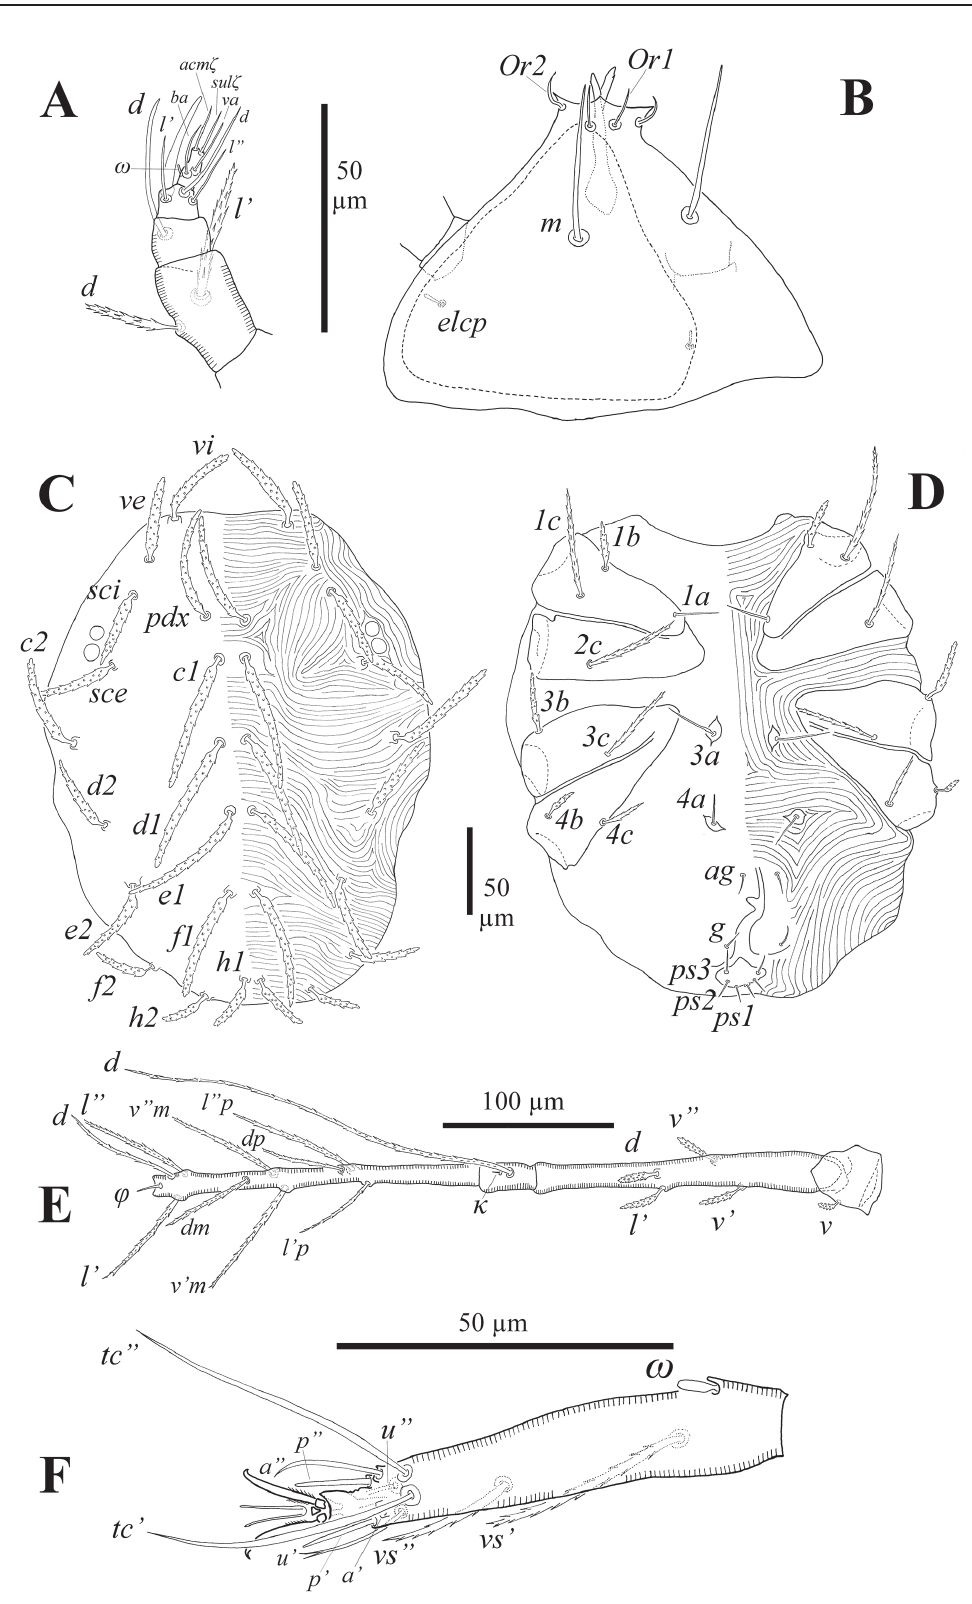
Fig. 1. Neophyllobius cibyci sp. nov., ♀, holotype. A . Palp. B . Subcapitulum. C . Dorsal idiosoma. D . Ventral idiosoma. E . Trochanter–tibia of leg I. F . Tarsus